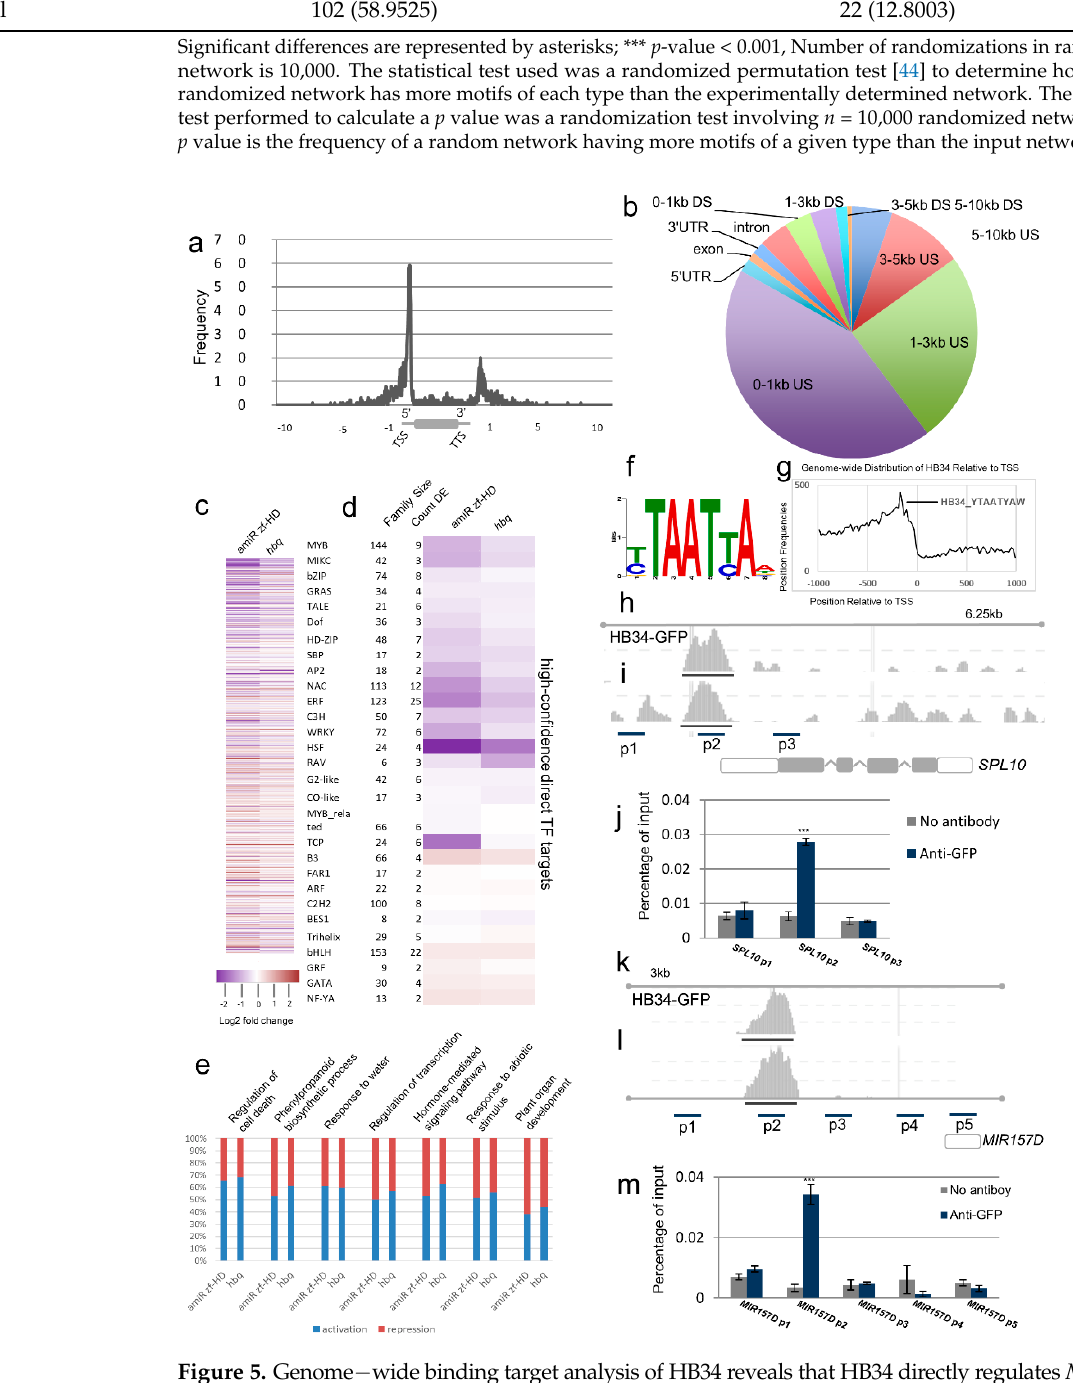
Figure 5. Genome − wide binding target analysis of HB34 reveals that HB34 directly regulates MIR157D and SPL10 via an FFL. ( a ) Frequency of HB34 binding sites in Arabidopsis gene models revealed strong enrichment in the regions within ±0.5 kb of transcription start and stop sites. ( b ) Genome-wide distribution of binding peaks in genic regions, DS: downstream, US: upstream. ( c ) Heat map of direct HB34 targets with altered expression in zf − hd mutants. ( d ) Heat map of average gene expression of direct HB34 targets, grouped by TF family. ( e ) Relative proportion of acti- vated/repressed genes associated with enriched GO terms among the directly bound targets of HB34. ( f ) Genome browser view showing HB34 ChIP − seq reads aligned near SPL10 and regions p1, p2, and p3 selected for ChIP − qPCR validation. ( g ) ChIP − qPCR analysis of HB34 in the SPL10 pro- moter region and p1, p2, and p3 regions as depicted in panel f. ( h , i ) Genome browser view showing HB34 ChIP-seq reads aligned near MIR157D and regions p1 − p5 regions selected for ChIP − qPCR validation. ( j ) ChIP − qPCR analysis of HB34 in the MIR157D promoter region. ( k , l ) Analysis of HB34 binding sites from ChIP-Seq and RNA − seq datasets revealed enrichment of a novel motif (YTAATYAW). ( m ) Genome − wide distribution of the novel motif YTAATYAW at specific positions relative to the TSS of genes with HB34 binding sites. ( j , m ) The result is mean ± SD (Student’s t -test, p < 0.001 ***) Table 1. Network motif analysis comparing Col-0 and zf-hd mutants.